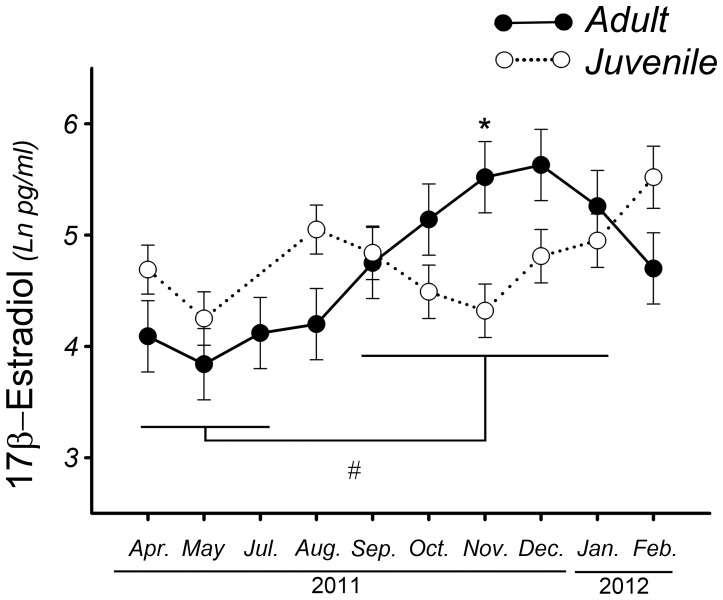
Annual changes in 17β-estradiol plasma levels of Greater Rhea adult females (solid line-filled circle) compared with juvenile rhea females (dashed line-empty circle), showing the differences in November (*).
# shows differences between April-July and September-January in Greater rhea adult females. Results are expressed as mean ± standard error; adult females n = 11, chick females n = 4; * and # denote p<0.01.